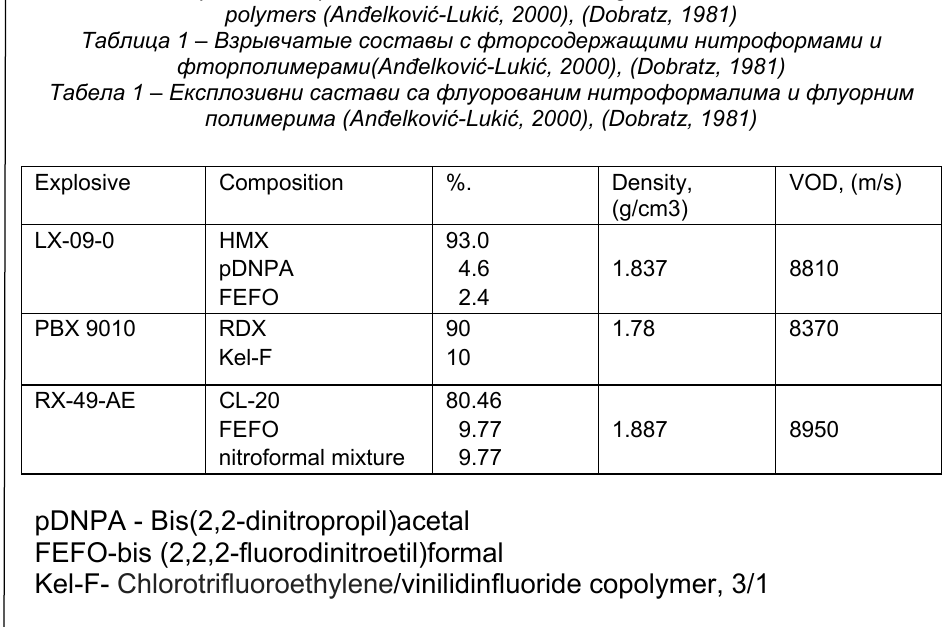
Table 1 – Explosive compositions fluorinated containing nitro formals and